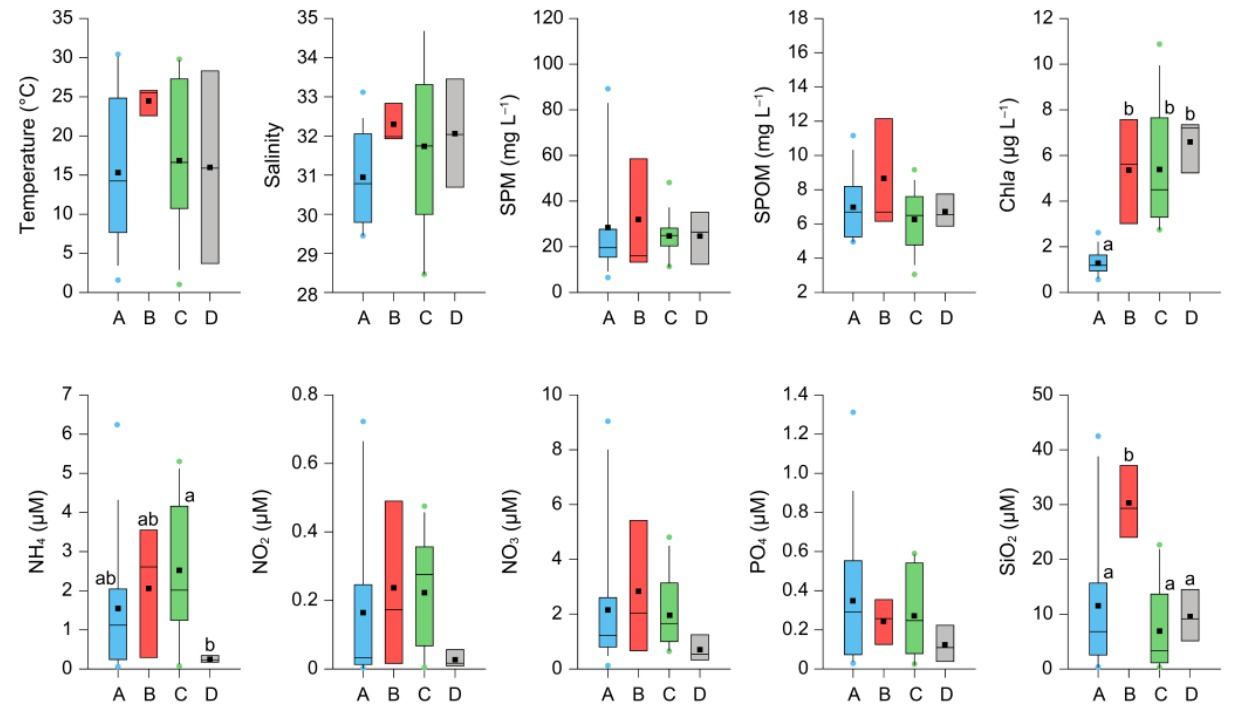
Figure 6. Box-and-whisker plots of environmental attributes in four clusters of phytoplankton community compositions, including temperature, salinity, suspended particulate matter (SPM), suspended particulate organic matter (SPOM), chlorophyll a (Chl a ), ammonium (NH 4 ), nitrate (NO 2 ), nitrate (NO 3 ), phosphate (PO 4 ), and silicate (SiO 2 ). The horizontal line and black square inside the box indicate the median and mean values of each cluster, respectively. The significance of the differences in environmental variables among those clusters was tested using a Kruskal–Wallis test, followed by a Mann–Whitney pairwise comparison test. The same superscript indicates a nonsignificant difference between medians ( p > 0.05).